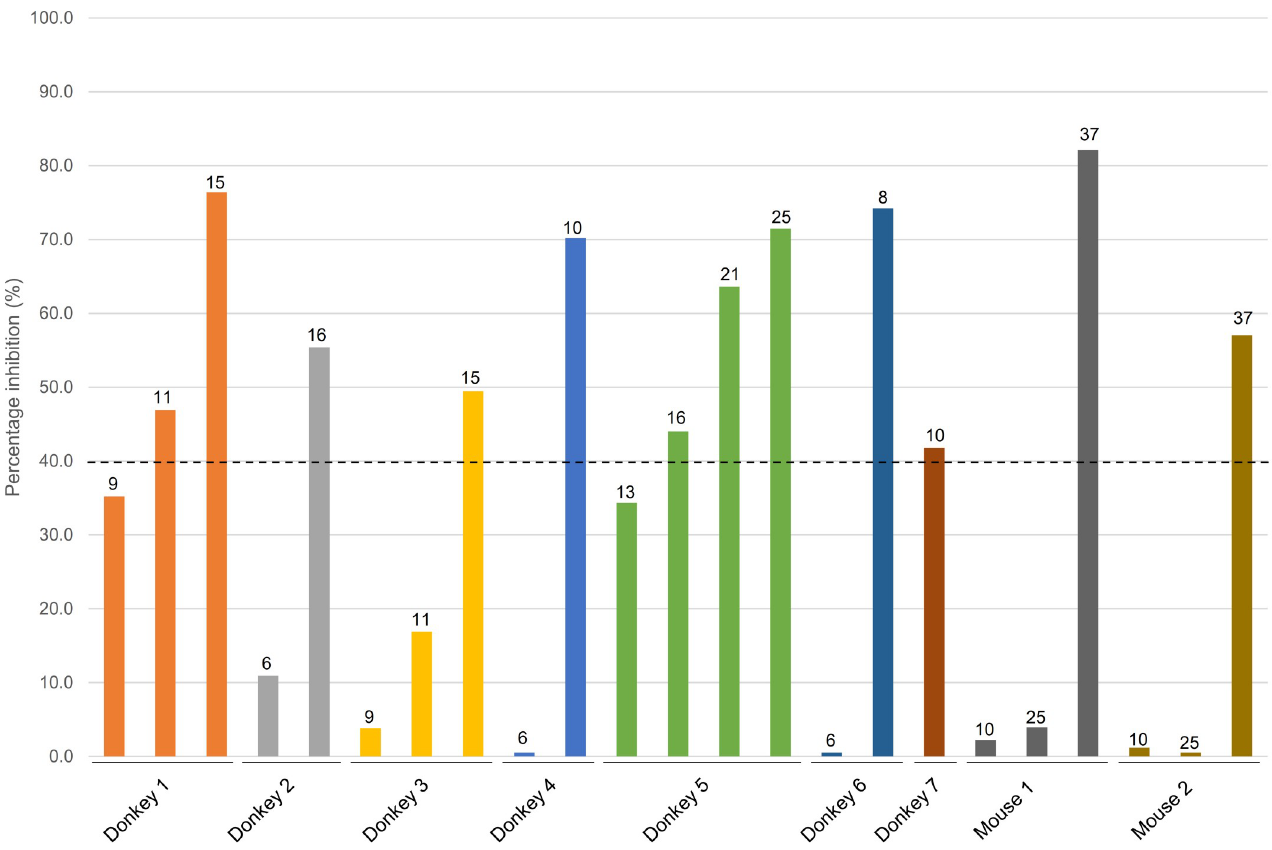
Fig 5. Using the lipopolysaccharide-based competitive ELISA (cELISA) to detect anti-LPS antibodies in seven donkeys and two mice inoculated with B . mallei . The donkeys were challenged via the following routes: oral injection at inoculum of 1.0 × 10 9 CFU/mL (donkeys 1 and 2), oral injection at inoculum of 1.0 × 10 8 CFU/mL (donkey 3), direct feeding through water (donkey 4), direct feeding through feed (donkey 5), intranasal spray (donkey 6), and subcutaneous injection (donkey 7). The two mice (mouse 1 and 2) were inoculated twice with non-viable B . mallei via intraperitoneal injection. Numbers on top of bars indicate the day post infection (donkey) or the day after the first inoculation (mouse) on which sera was collected. Data indicate cELISA values calculated as the percentage inhibition (PI) of mAb B5 binding. The defined cELISA cutoff value (PI of 39.6%) is indicated by the dashed